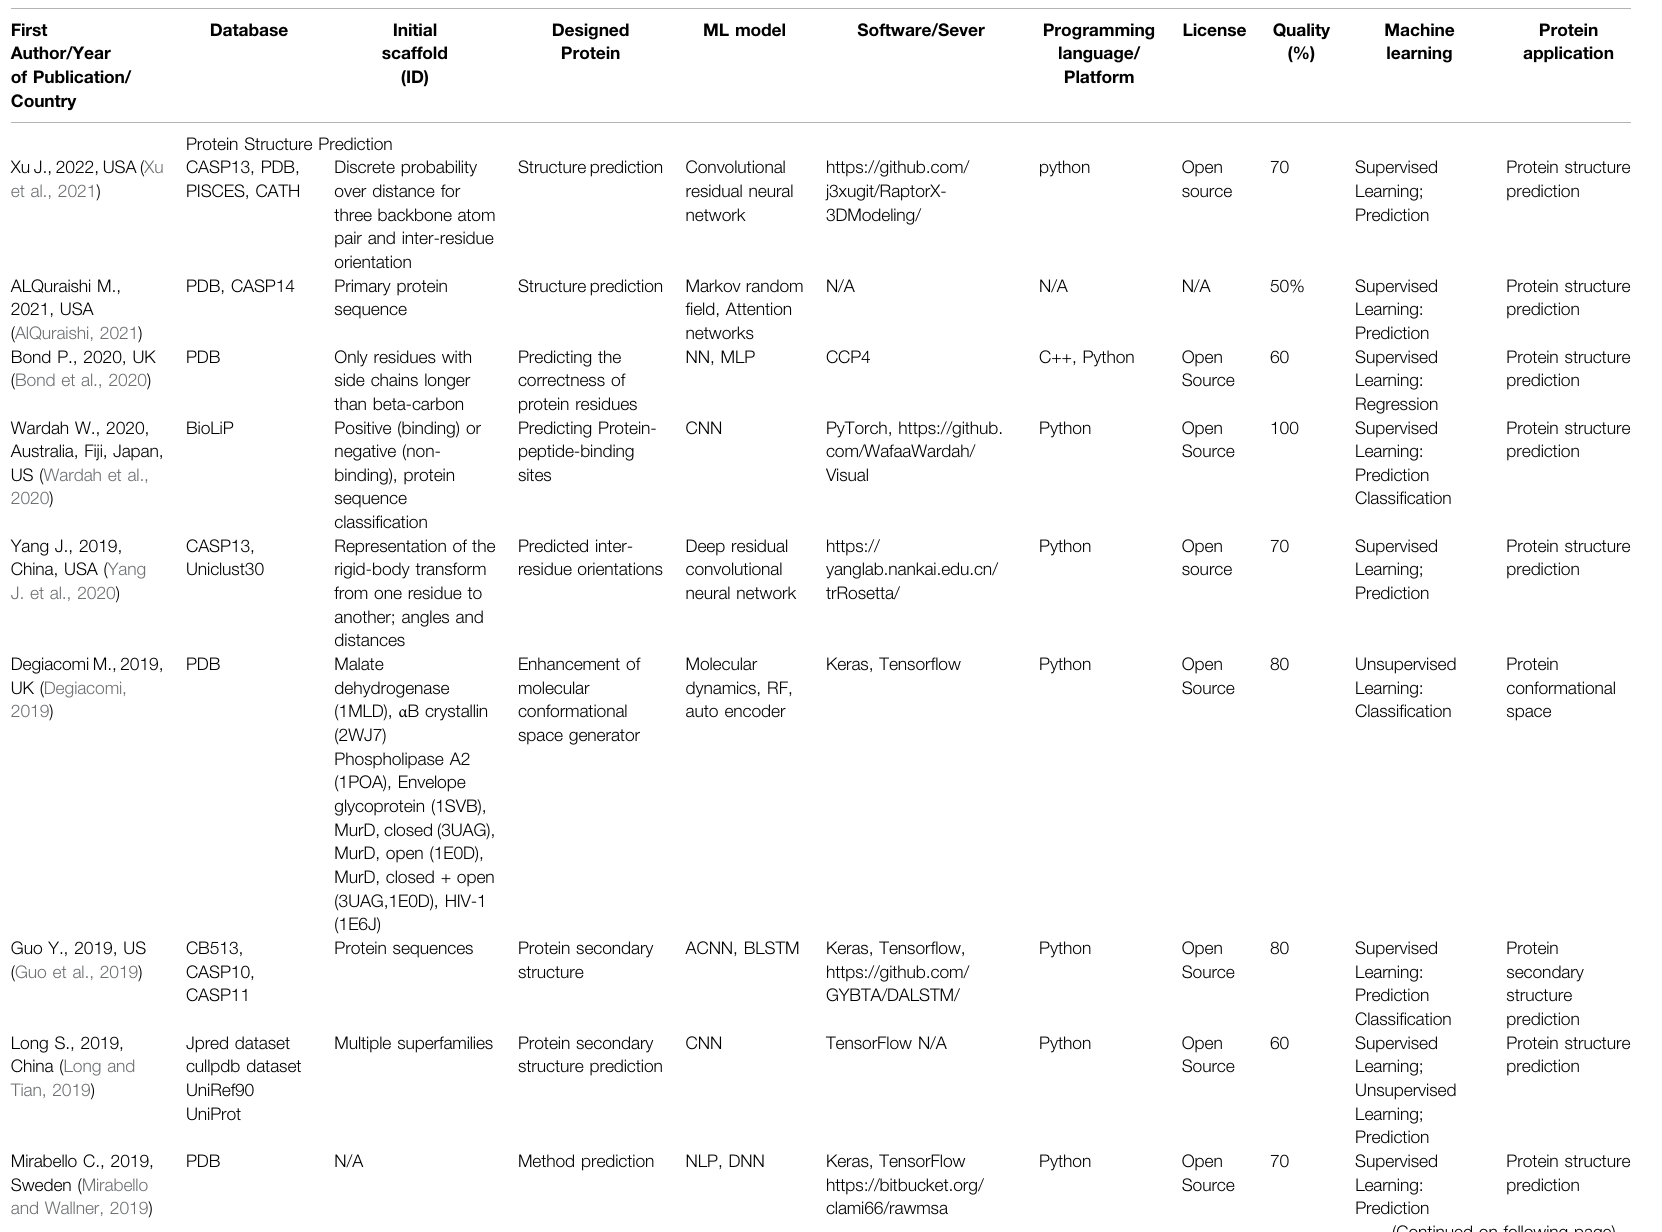
TABLE 5 | An overview of the protein structure prediction articles with the quality